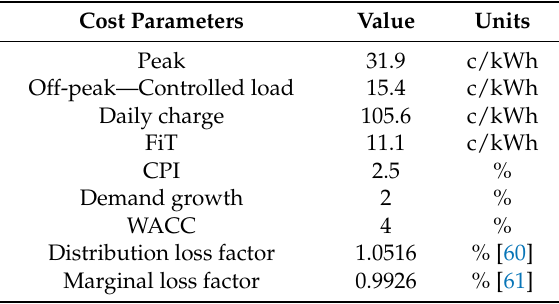
Table 5. Retail and price input